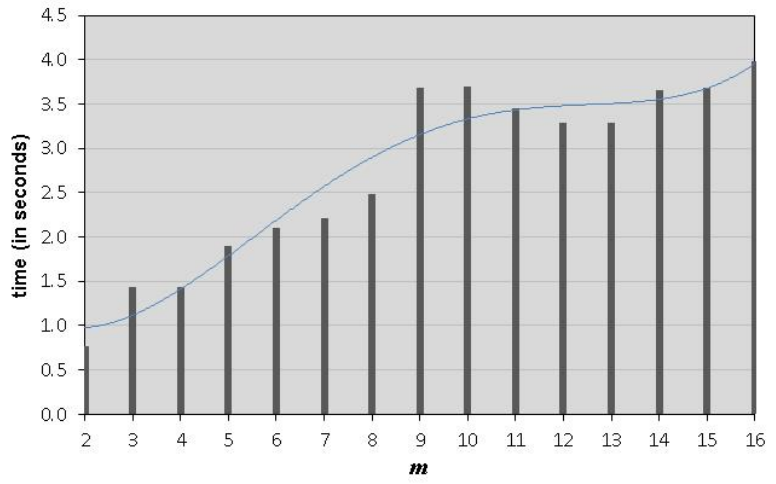
Figure 3. Illustration of run time behaviour of the hybrid genetic algorithm for different values of m .